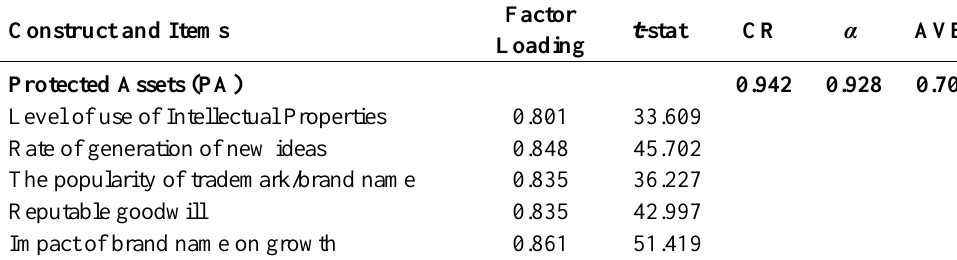
Table 1: Reliability and Validity of First-Order Constructs Construct and